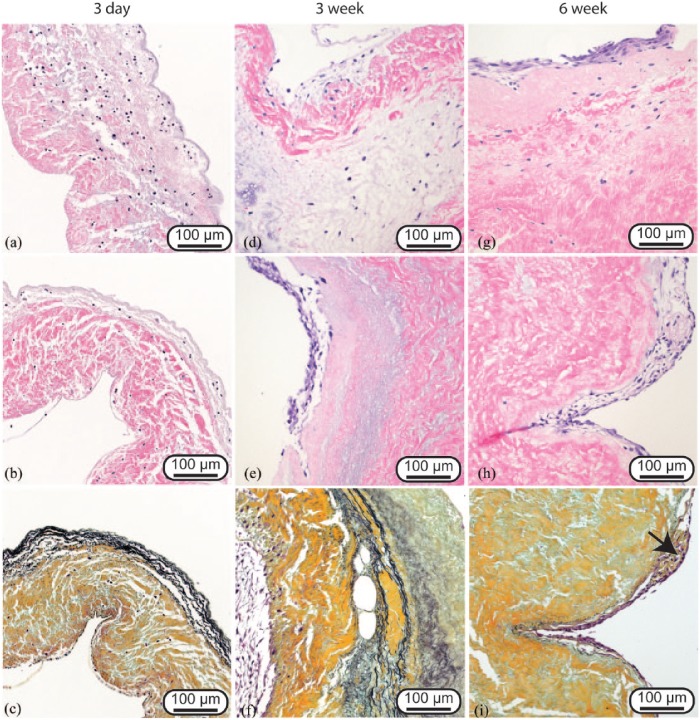
Representative H&E (a, b, d, e, g, and h) and Movat’s pentachrome (c, f, and i) images of 3-day (a–c), 3-week (d–f), and 6-week (g–i) bioreactor-conditioned heart valve leaflets. Three-day-conditioned leaflets exhibited high interstitial recellularization. Three-week- and 6-week-conditioned valves exhibited decreased interstitial recellularization but increased numbers of cells on the leaflet surface, often in multilayered clumps. Movat’s pentachrome staining demonstrated preservation of the leaflet structure (collagen, gold; elastin, black; and GAG, blue). There was evidence of collagen deposition within some samples of the 6-week-conditioned valves (black arrow).